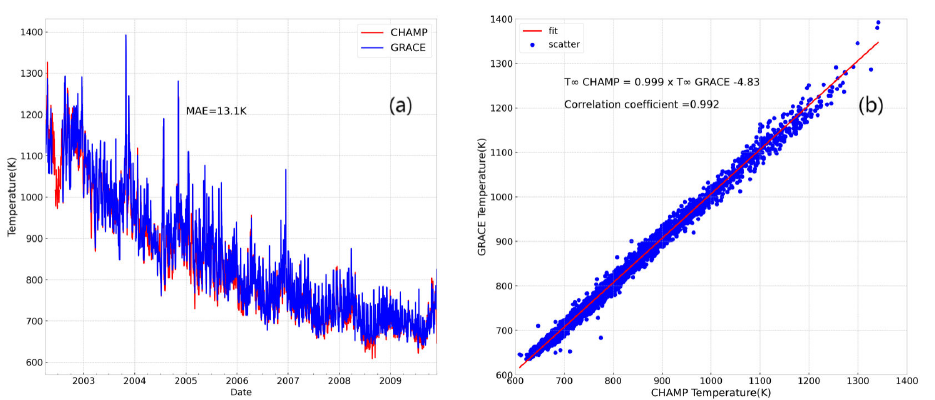
Figure 2. ( a ) Daily exospheric temperatures derived from CHAMP and GRACE satellites during 2002–2010, and ( b ) their statistical results are also